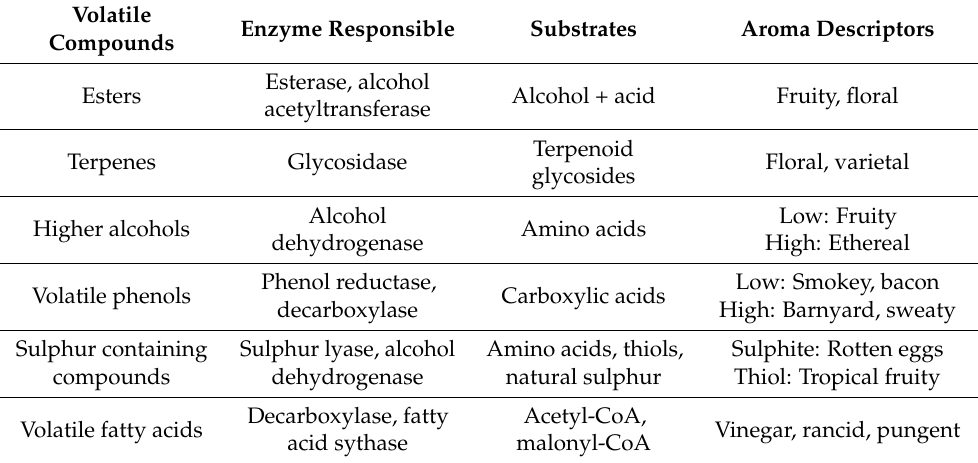
Table 1. Common volatile compounds produced during fermentation complete with the enzymes responsible, initial substrates, and their effect on the aroma.